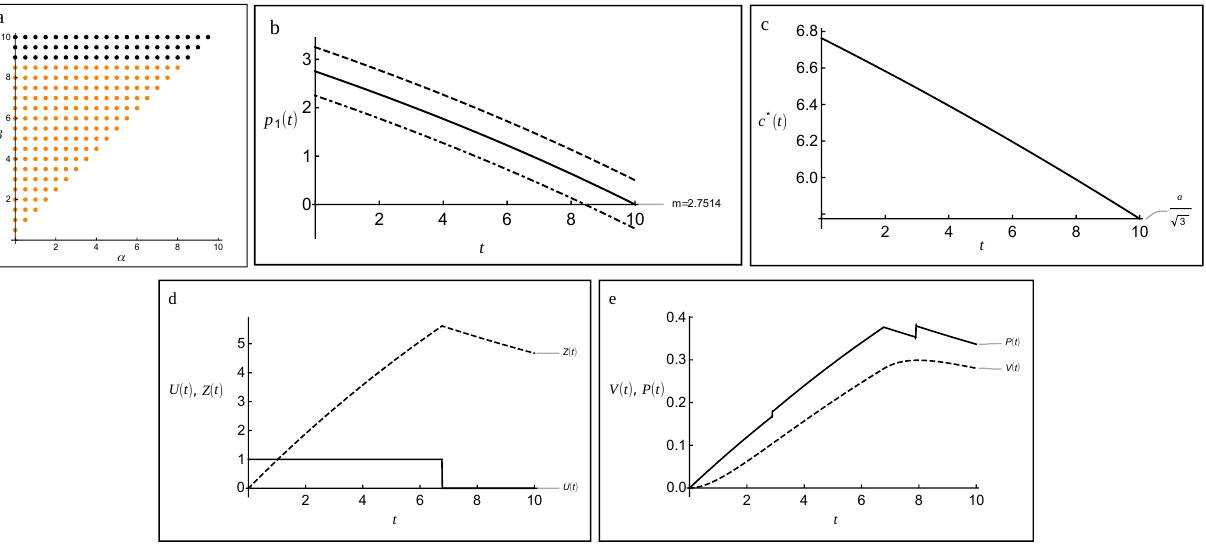
Figure 8. ( a ) Initial state; ( b ) dependence p 1 ( t ) , graphs of the functions p 1 ( t ) ± 0.5 are given for clarity; ( c ) the price function depending on the time; ( d ) functions U , Z depending on the time; ( e ) functions V , P depending on the time. Values of the parameters of the dynamic system: a = 10, U 0 = 1, T = 10, k 1 =